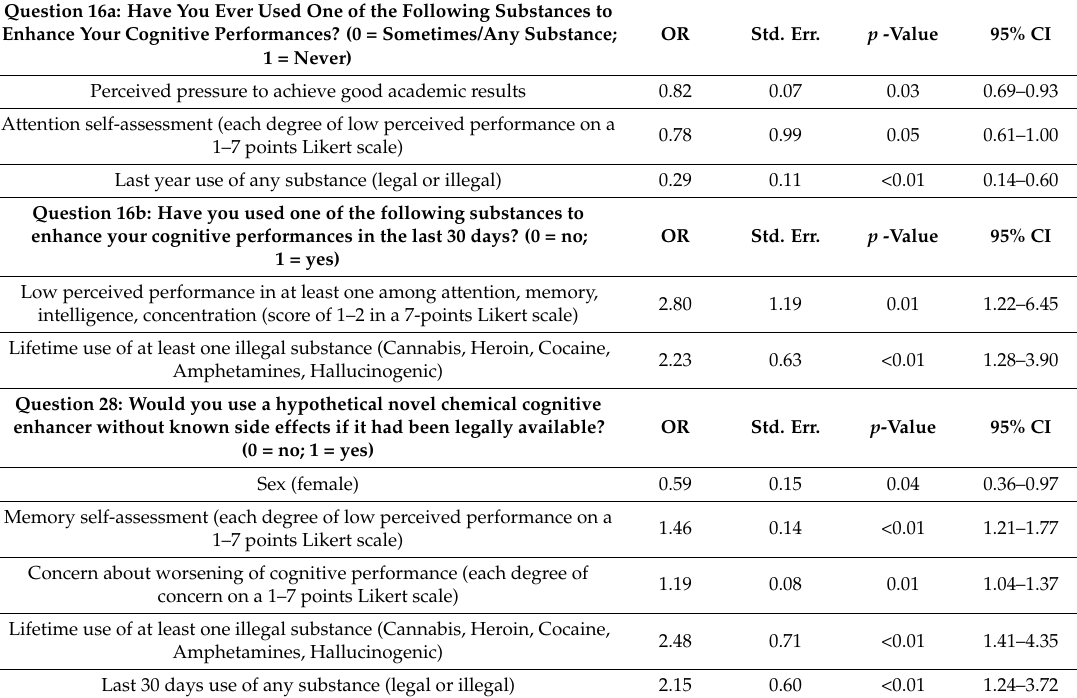
Table 4. Results of the multiple binary logistic